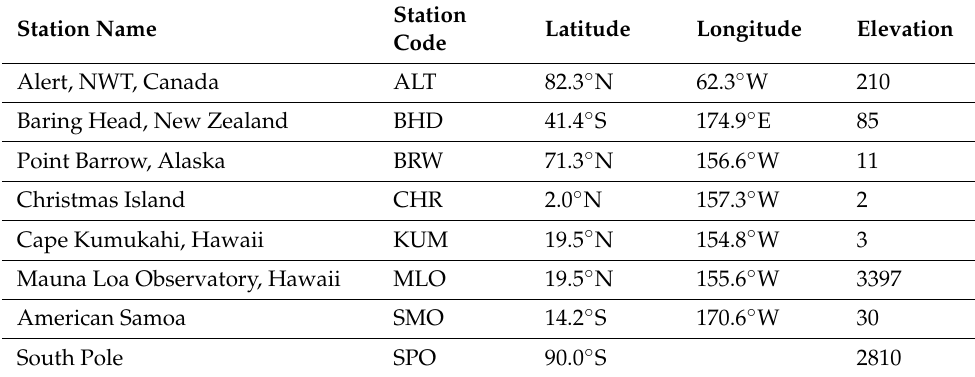
Table A1. SIO CO 2 observation stations.